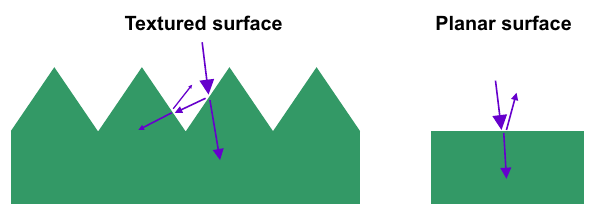
Figure 5. Schematic comparison of the reflected light on textured and planar silicon